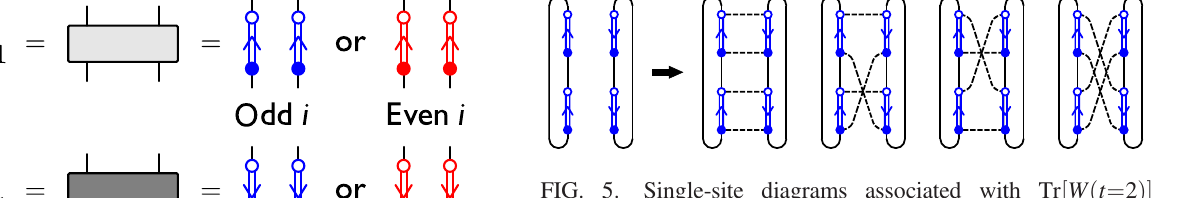
FIG. 5. Single-site diagrams associated with Tr ½ W ð t ¼ 2 Þ(cid:2)